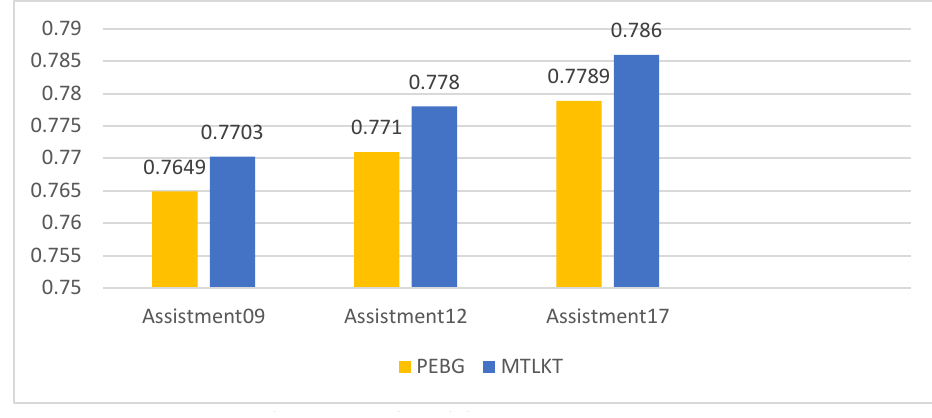
Figure 5. Comparison with pre-trained model.